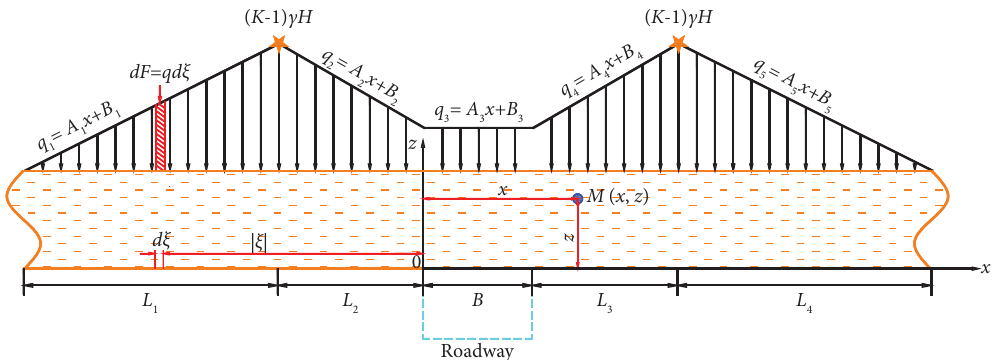
Figure 5: Stress increment mechanical